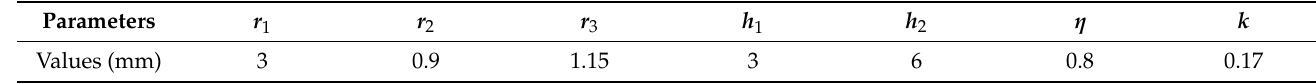
Table 1. Parameters of the heat source model.